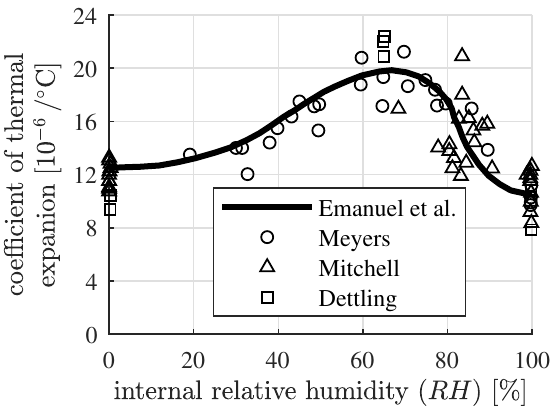
Figure 1. Dependence of the thermal expansion coefficient on the internal relative humidity: experimental data from Meyers [8], Mitchell [9] and Dettling [10], measured on mature cement paste with the initial water-to-cement mass ratio ranging between 0.12 and 0.40; the curve was depicted by Emanuel and Hulsey